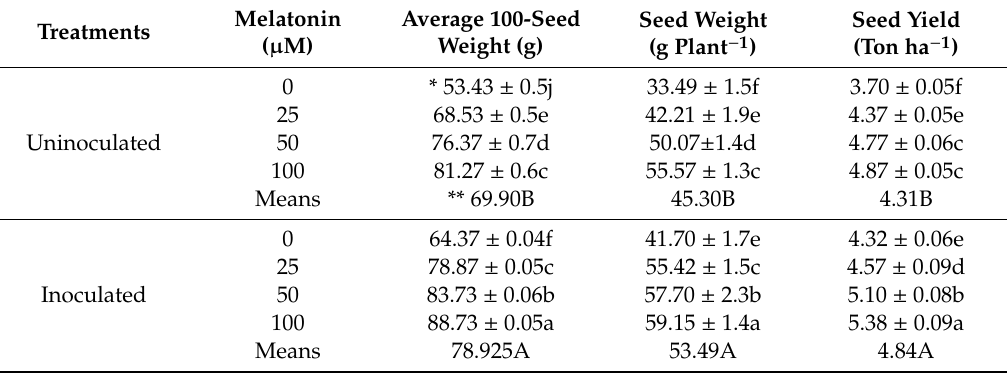
Table 5. E ff ect of EPS-producing bacteria and melatonin on yield components of faba bean grown in location two (non-saline